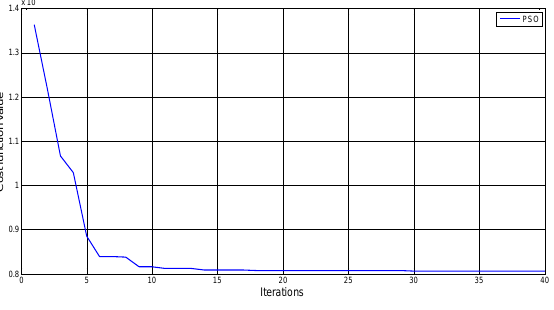
Figure 12. Evolution of fitness value vs. iterations in PSO.